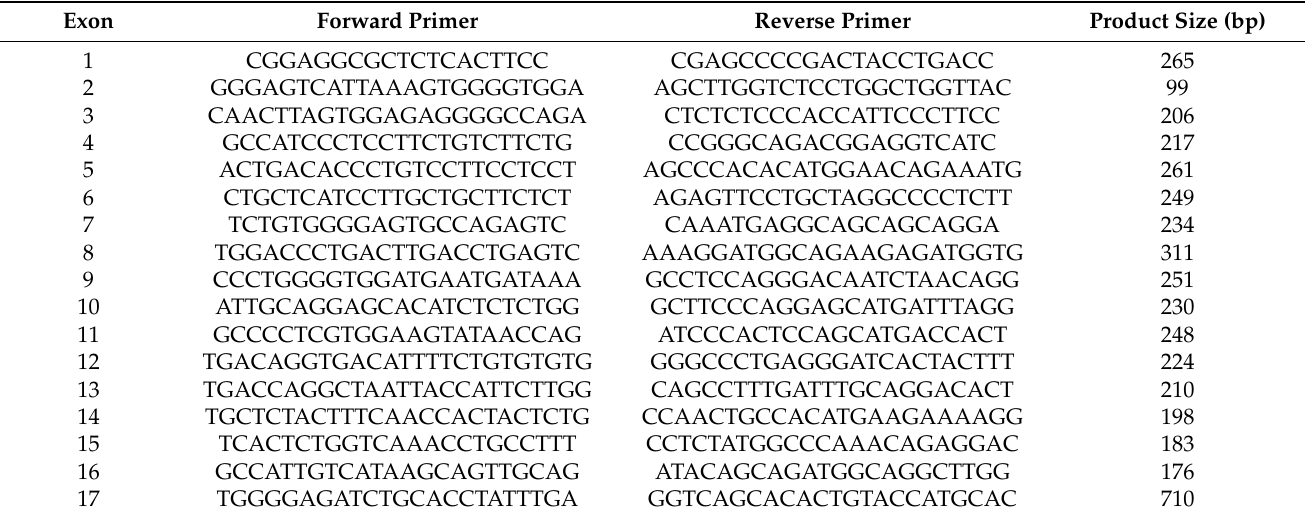
Table 1. Primers for the TGFBI DNA